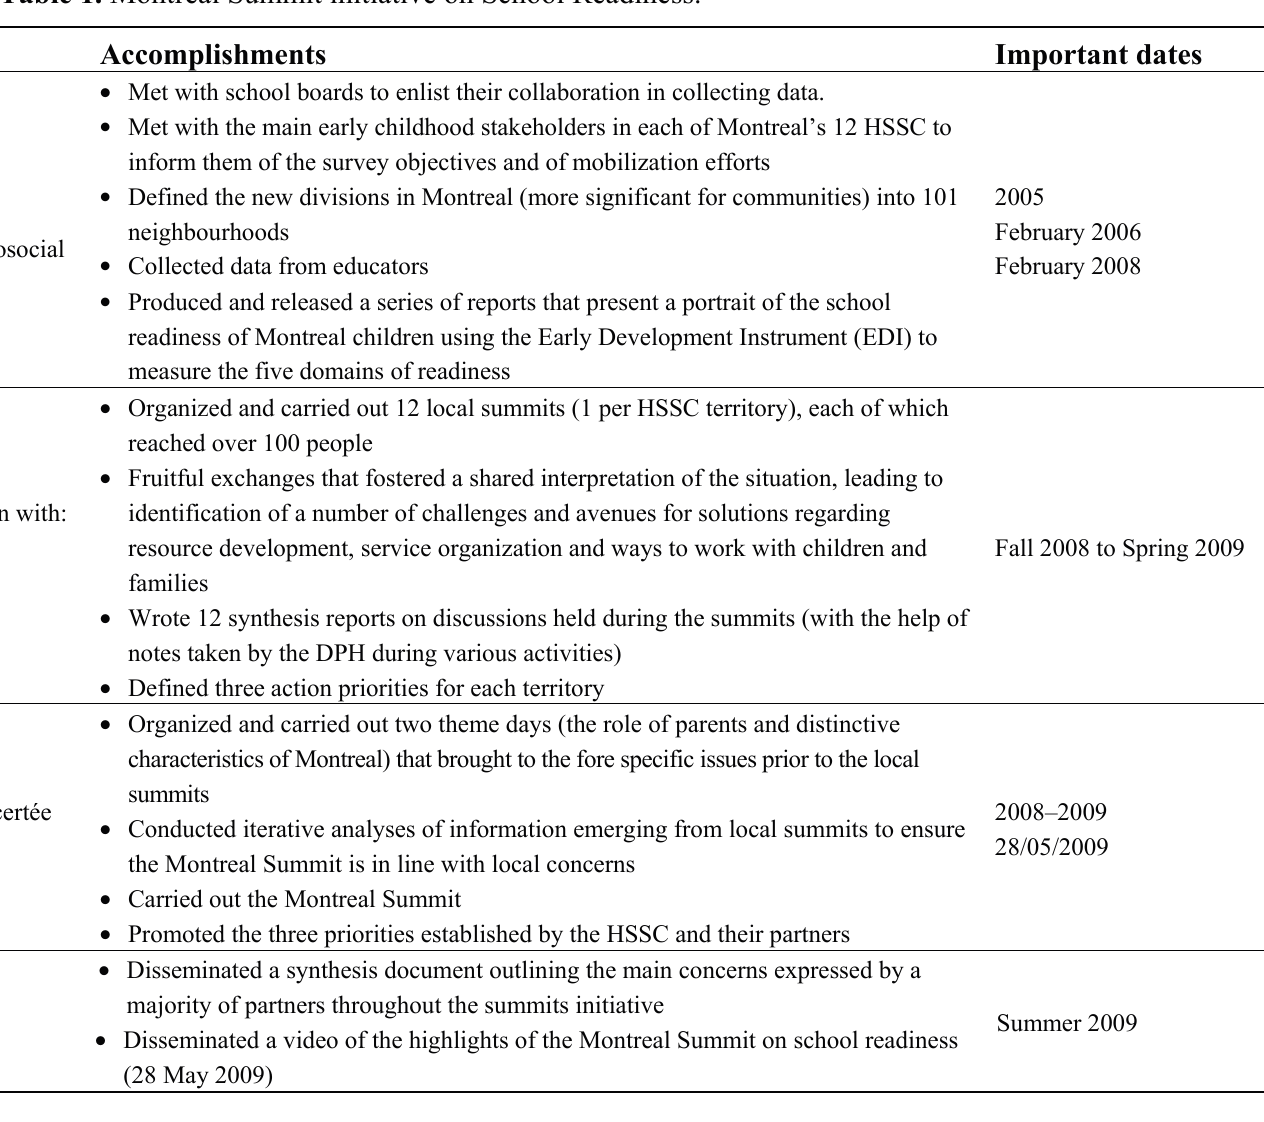
Table 1. Montreal Summit initiative on School